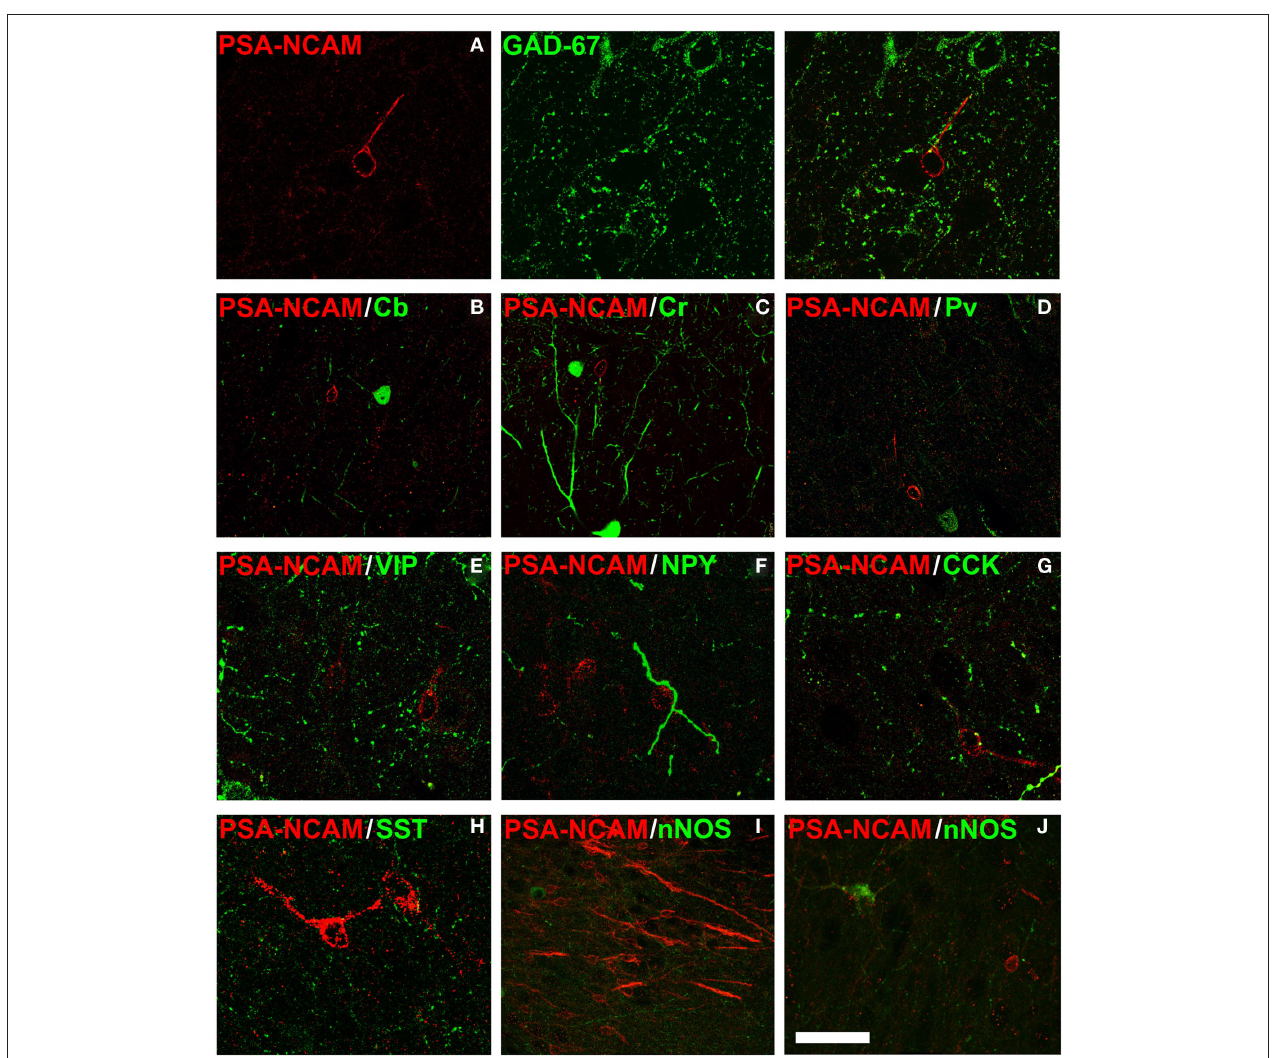
peptide (VIP), (F) neuropeptide Y (NPY), (g) cholecystokinin (CCK), (H) somatostatin (SST), or (i,J) : neural isoform of the nitric oxide synthase (nNOS). All the images in this figure are 2D projections of three consecutive confocal planes located 1 μm apart. Scale bar: 25 μm for (A,e–H) ; 50 μm for (B–D,J) ; 75 μm for (i)